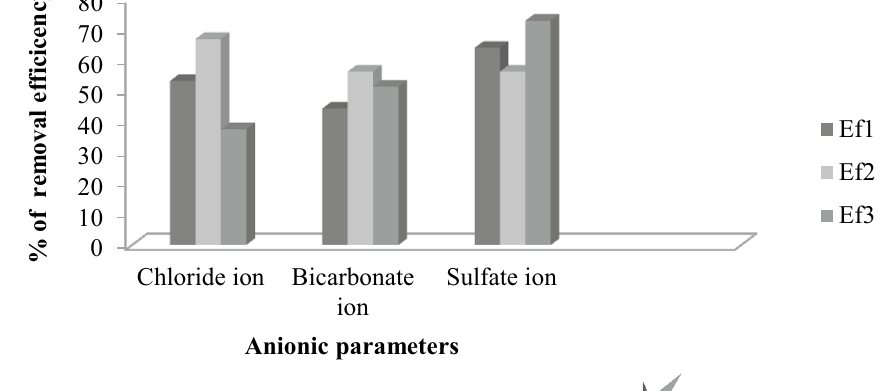
Fig. 7 Percentage removal of Cl − , HCO 3− and SO 42− ions from effluents after treatment with PAC